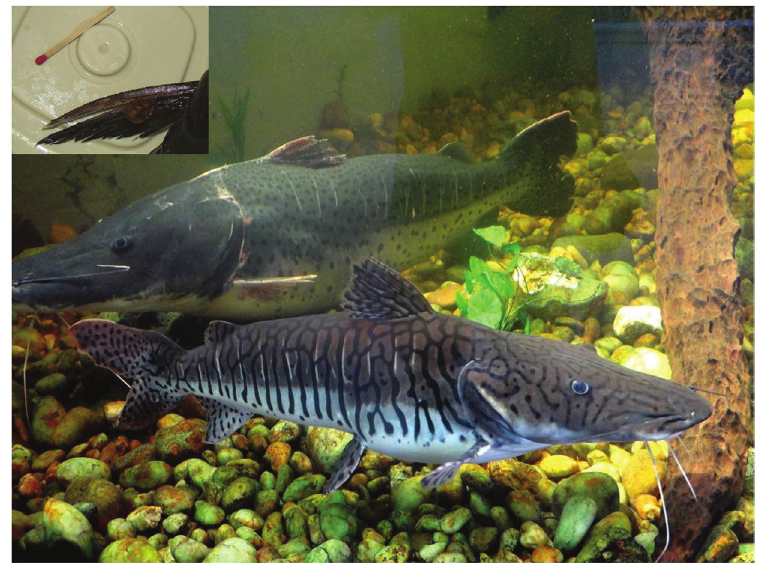
Figure 1 - Pseudoplatystoma corruscans , the pintado or spotted catfish (above) and Pseudoplatystoma reticulatum , the cachara or striped catfish (below). Detail: stinger in the pectoral fin. Photos: Vidal Haddad